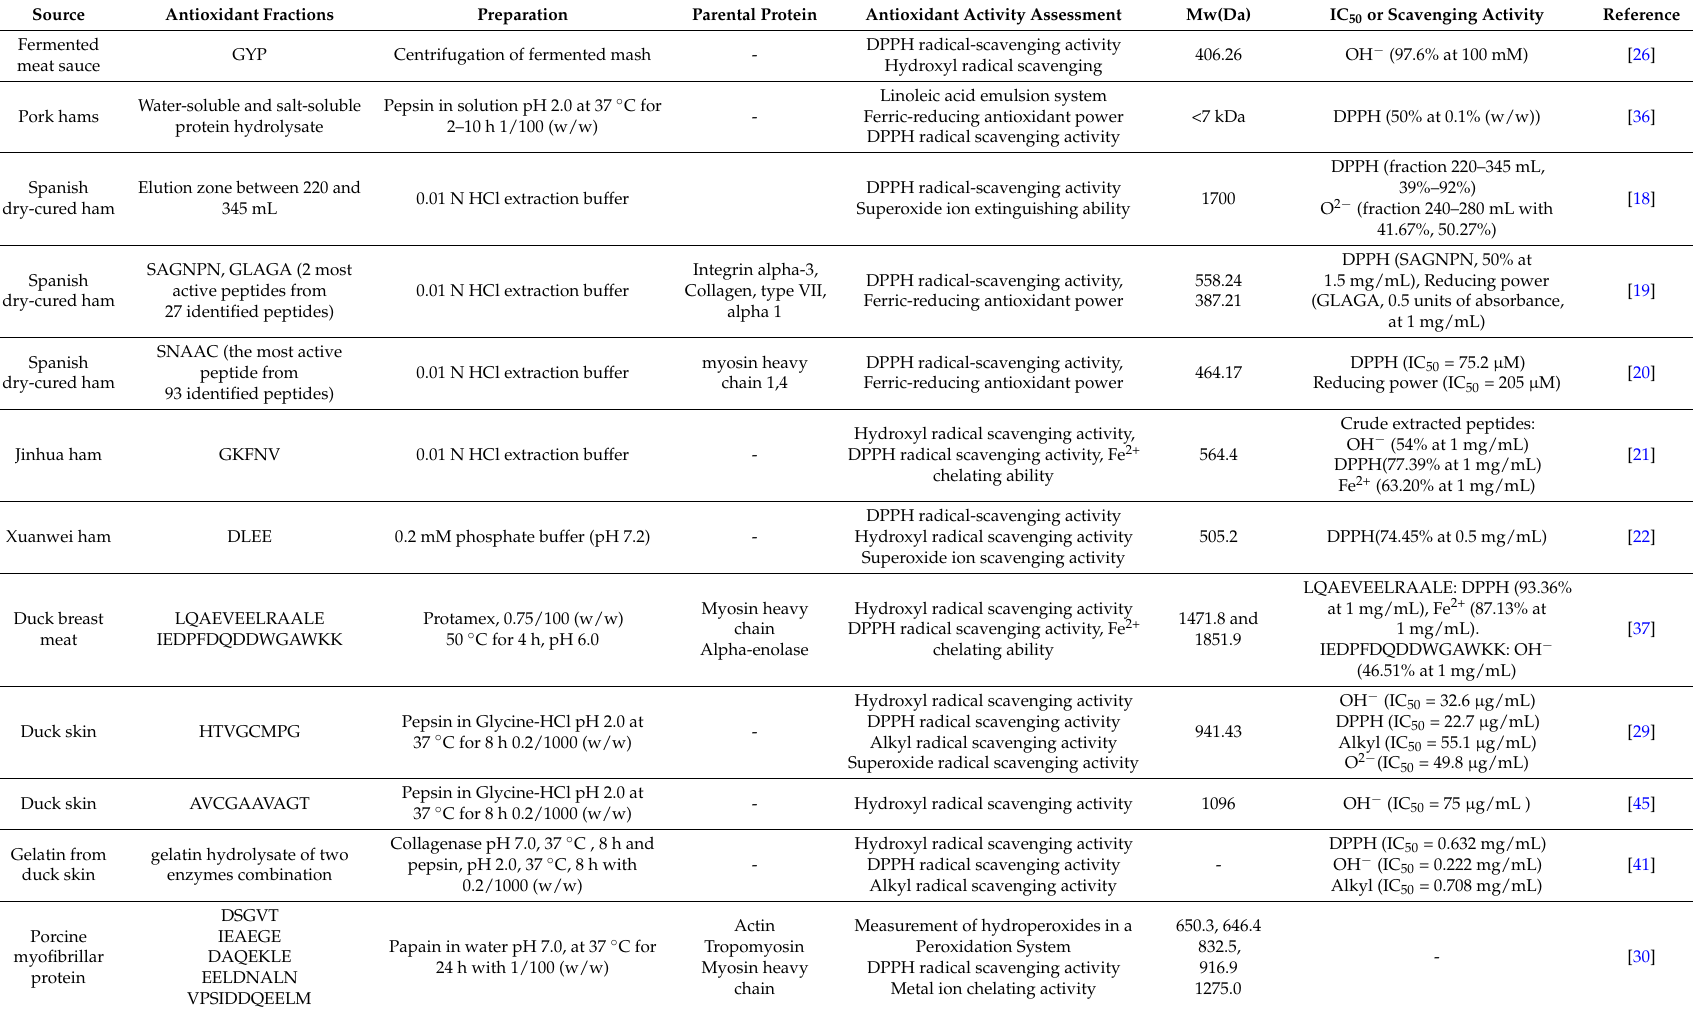
Table 1. Antioxidant hydrolysate and peptides generated from meat proteins and